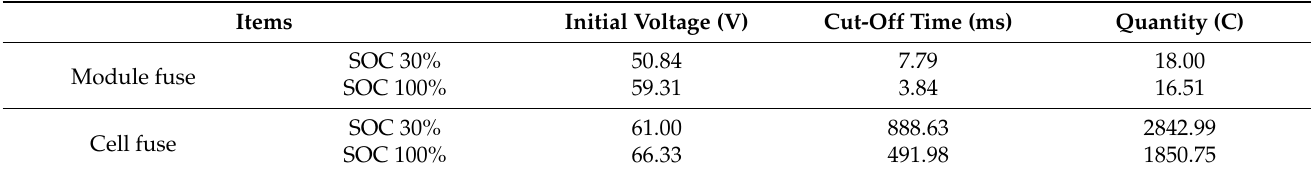
Table 5. Characteristics of battery module’s external short-circuit test according to protection device and